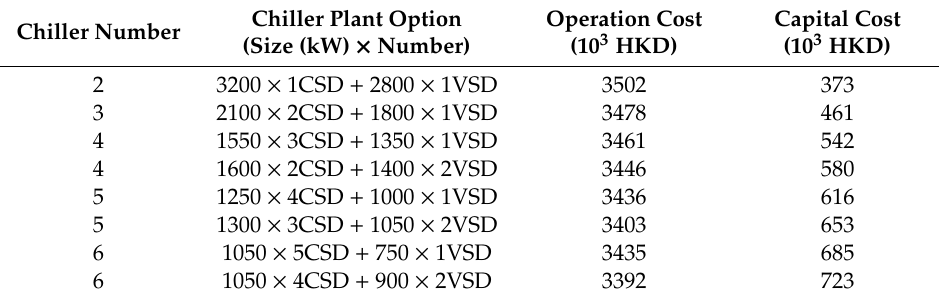
Table 5. Annual operation cost and annualized capital cost of di ff erent design options. Chiller Plant Chiller Number